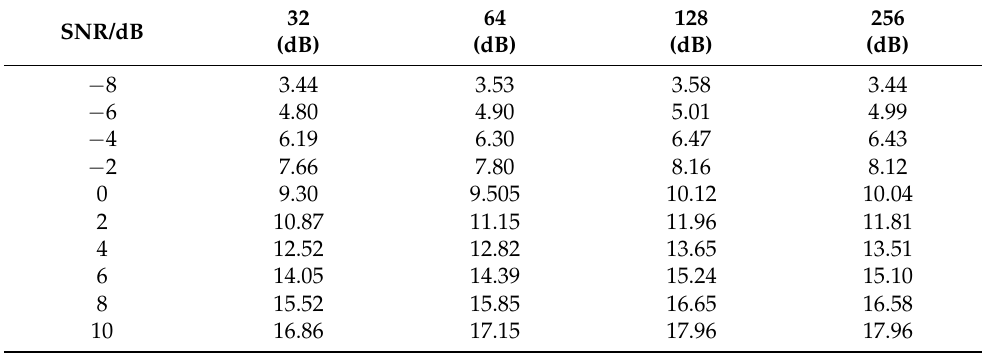
Figure 8. Comparison of noise reduction performance of different number of hidden nodes. Table 8. Specific data of noise reduction performance Comparison of different number of hidden layer nodes.